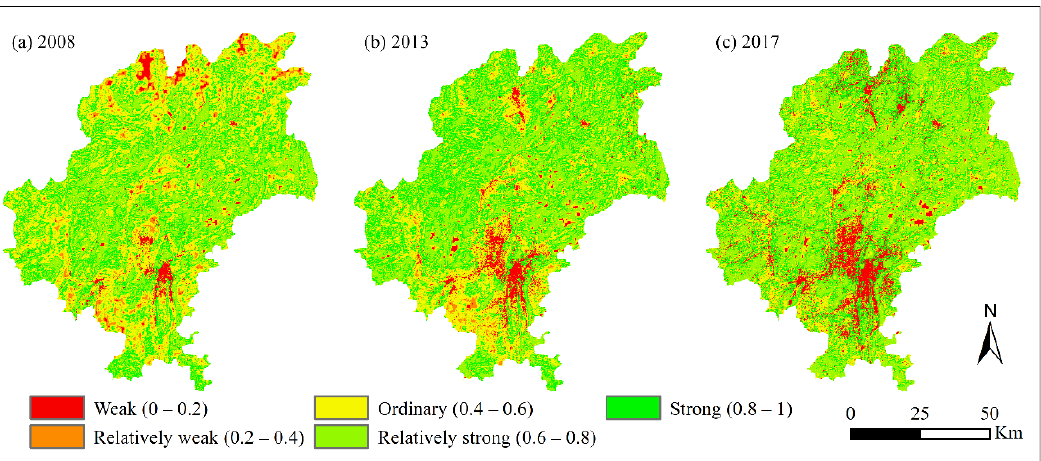
Figure 3. Distribution map of different ecosystem health classes in 2008 ( a ), 2013 ( b ) and 2017 ( c ).